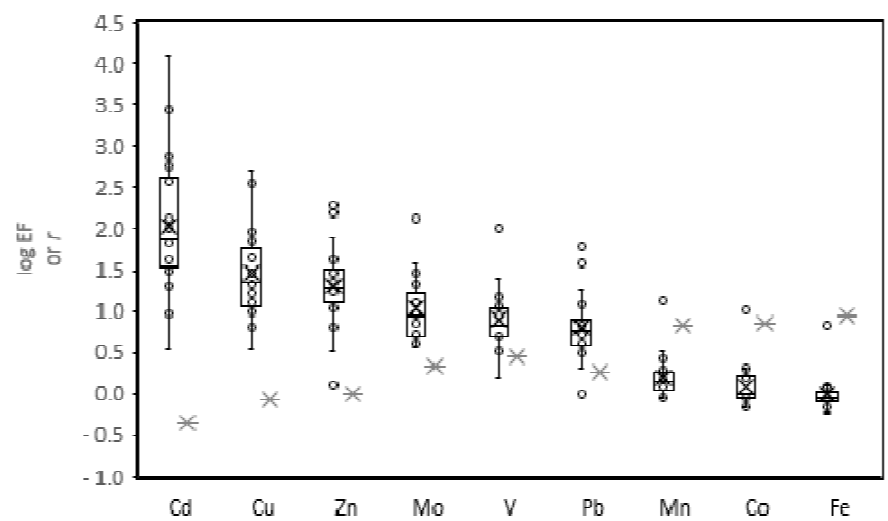
Figure 6. Enrichment factor (black whiskers-box) and Pearson correlation coefficient r with the mineral dust marker (Ti) (grey stars).